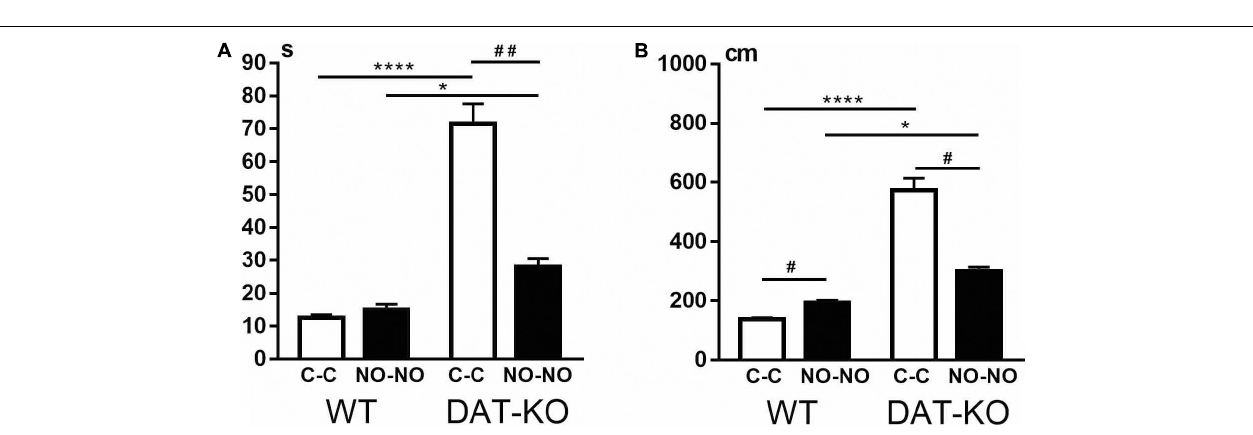
FIGURE 3 | Comparison of task fulfillment duration in seconds (A) and distances covered in centimeters (B) in WT and DAT-KO rats during the presentation of cubes (C-C, white columns) and novel objects (NO-NO, black columns); * or # p < 0.05; ## p < 0.01; **** p < 0.0001; one-way Kruskal–Wallis test with Dunn’s multiple-comparison post hoc test. WT, wild-type; DAT-KO, dopamine transporter knockout.